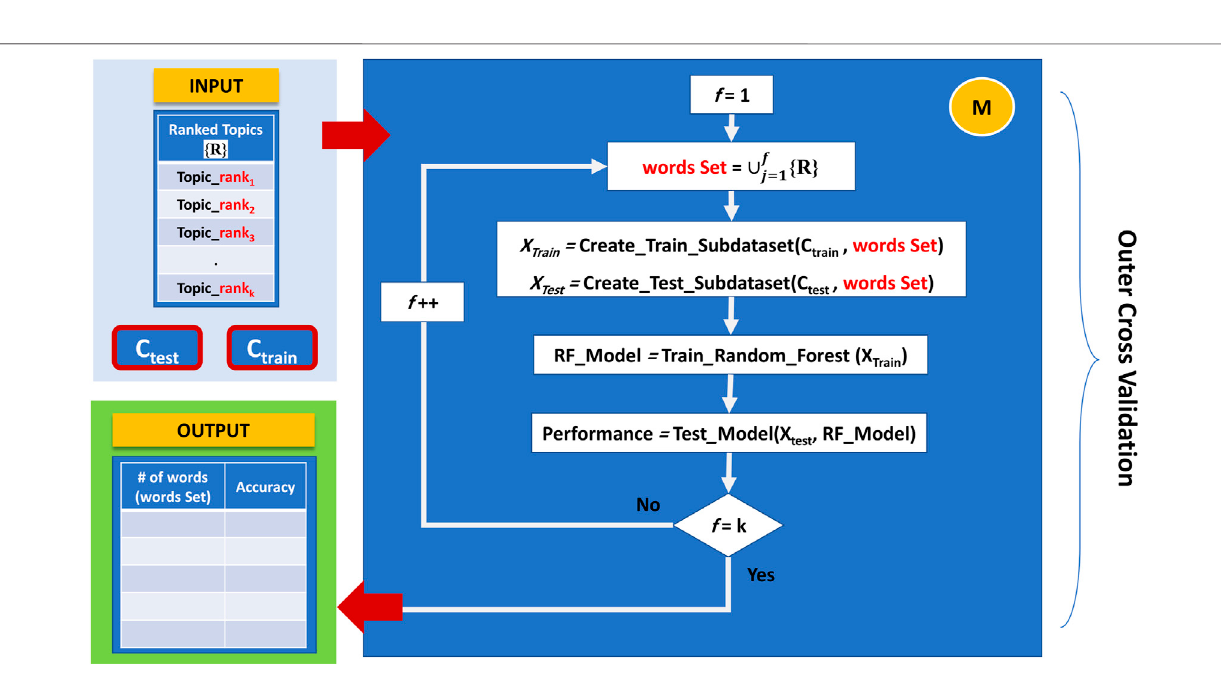
FIGURE 6 | The working principle of Component M: fi nding the best feature set, in terms of topics terms combinations, that provides the best performance.